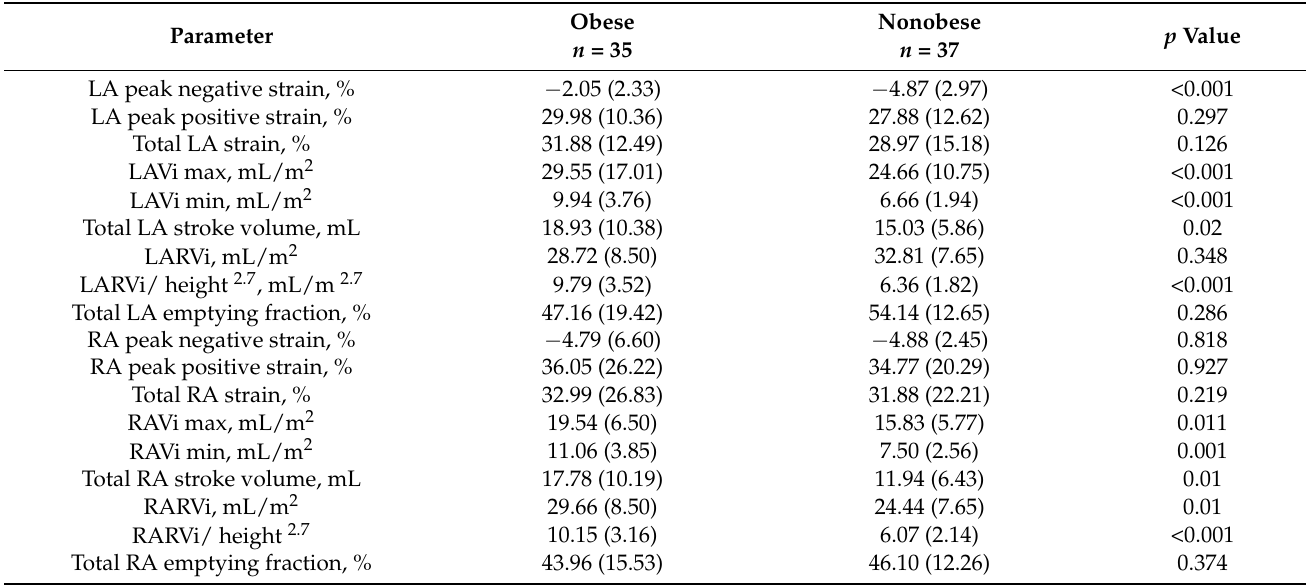
Table 3. Atrial longitudinal strain and volumetric data.